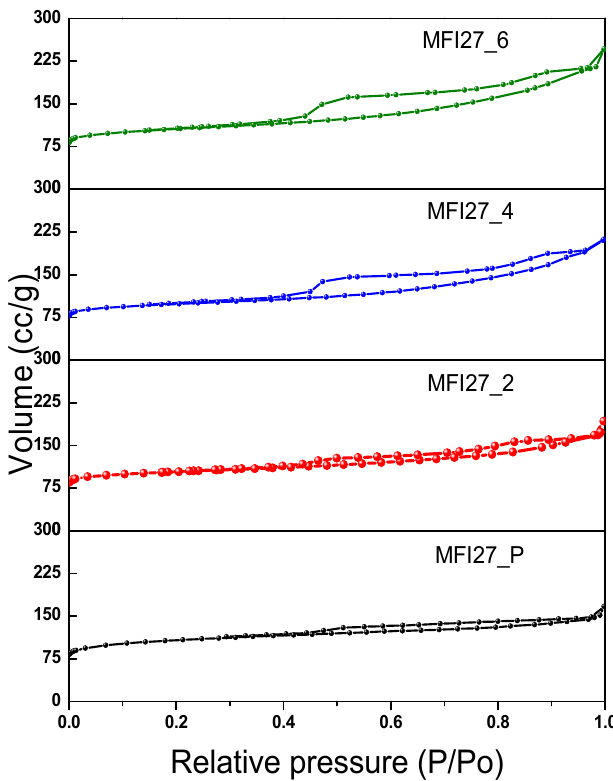
Figure 4. N 2 adsorption/desorption isotherms of as-received ZSM-5 and alkali-treated zeolite samples.